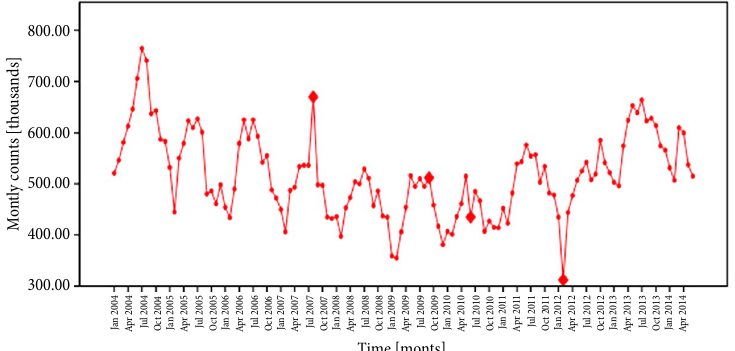
Figure 7. Outliers in time series of monthly rail passenger flows (in thousands) in Serbia (January 2004 – June